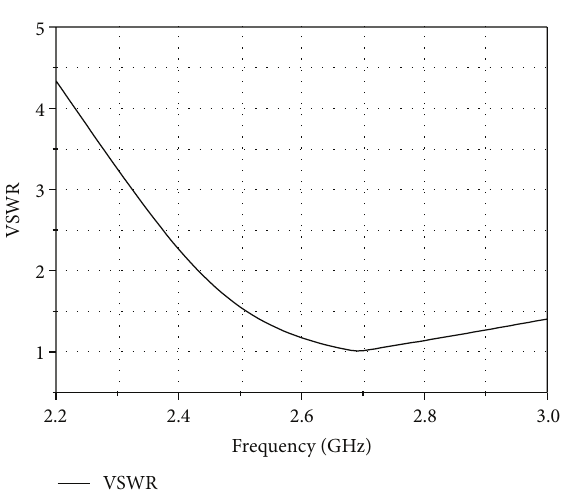
Figure 3: VSWR curve of the element in the isolated state.